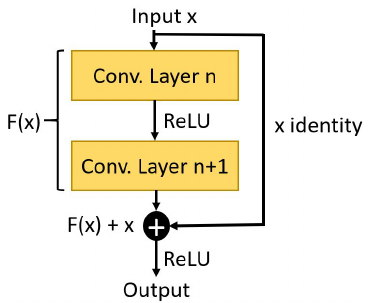
Figure 7. Example of a residual block. These skip connections perform identity mapping optimally and they add neither extra parameter nor computational complexity.